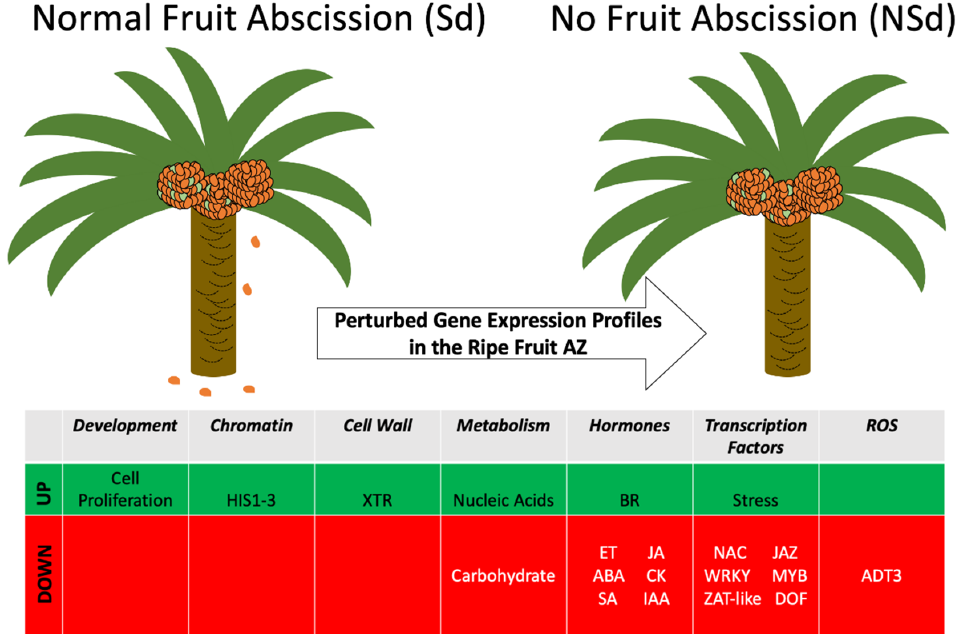
Figure 5. The non-abscission phenotype (NSd) of the E. oleifera palm is a result of both up- and downregulated gene expression in the ripe fruit variant AZ. When fruit are ripe, they abscise and fall to the ground and are found around the base of the normal palm, while no fruit is found at the base of the variant that does not undergo abscission. Green signifies globally higher, while red indicates lower transcript amounts in the NSd variant. DOF (Dof-type zinc finger DNA-binding family protein), NAC, (NAM, ATAF and CUC family member), JAZ (Jasmonate-Zim-domain protein), ADT3 (AROGENATE DEHYDRATASE 3), HIS1-3 (Histone H1-3), XTR (Xyloglucan endotransglycosylase-related protein) brassinosteroid (BR), Indole-3-acetic acid (IAA), ethylene (ET), jasmonate (JA), abscisic acid (ABA), cytokinin (CK), salicylic acid (SA).